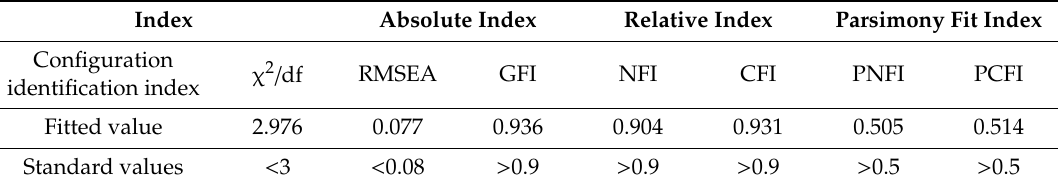
Table 6. Results of SEM fitting